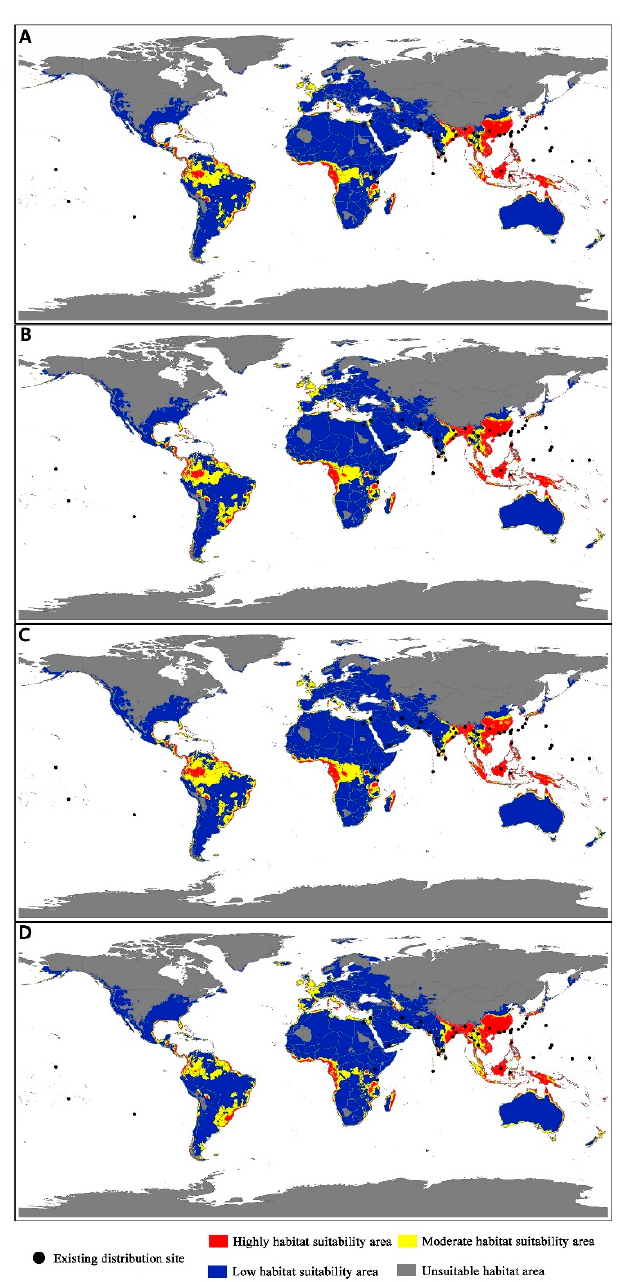
Figure 9. Future species distribution models of Icerya aegyptiaca on global scale under different climate scenarios predicted by MaxEnt. ( A ) 2050RCP4.5 (habitat suitability areas for the projected future distribution under the community climate system model (CCMA) and model for interdisciplinary research on climate (MIROC) representative concentration pathways (RCP) 4.5 climate change scenarios); ( B ) 2050RCP8.5; ( C ) 2070RCP4.5; ( D ) 2070RCP8.5.